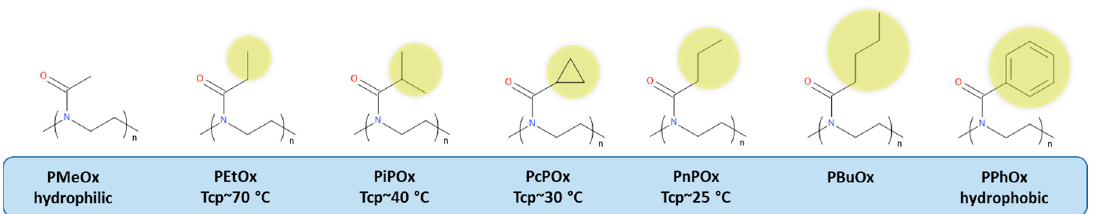
Figure 1. Chemical structure and water solubility of poly(2-oxazoline)s (POx) as a function of alkyl side chain.